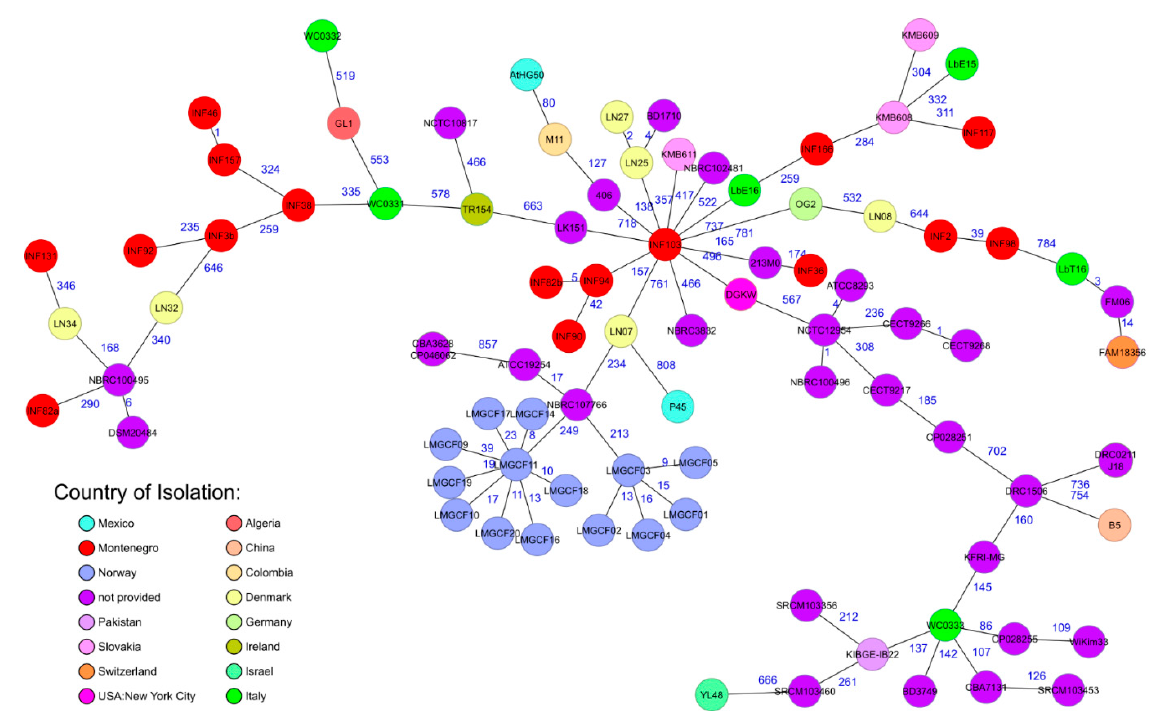
Figure 2. Minimum spanning tree (MST) based on cgMLST analysis of 88 Ln. mesenteroides isolates derived from GenBank and Montenegrin brine cheeses. Numbers on connection lines represent allelic differences between isolates. Isolates are colored according to their country of origin.